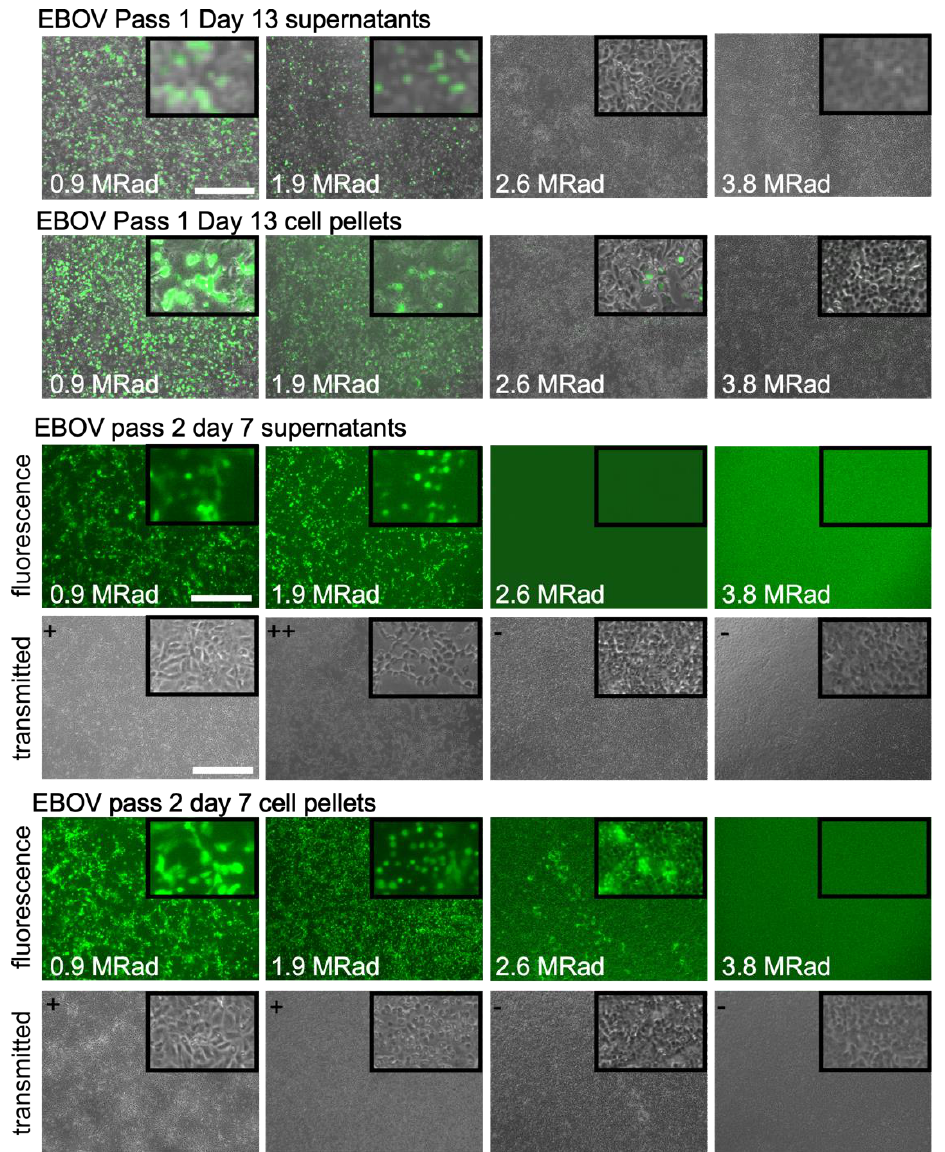
Figure 4. Inactivation of EBOV by gamma radiation. Images (bright field and fluorescence) were taken at the indicated times after irradiated material was used to inoculate flasks of fresh Vero cell monolayers and incubated for 13 days or passed onto fresh cells after 7 days as indicated. Both cell pellets and culture supernatants were evaluated for inactivation. Insets show isolated regions where infection was detected and are 5× magnification of the parent image. At top left of brightfield images grading for CPE is given with - = none, + = low and ++ = high CPE. Scale bar is 500 mm with all images taken at the same magnification.